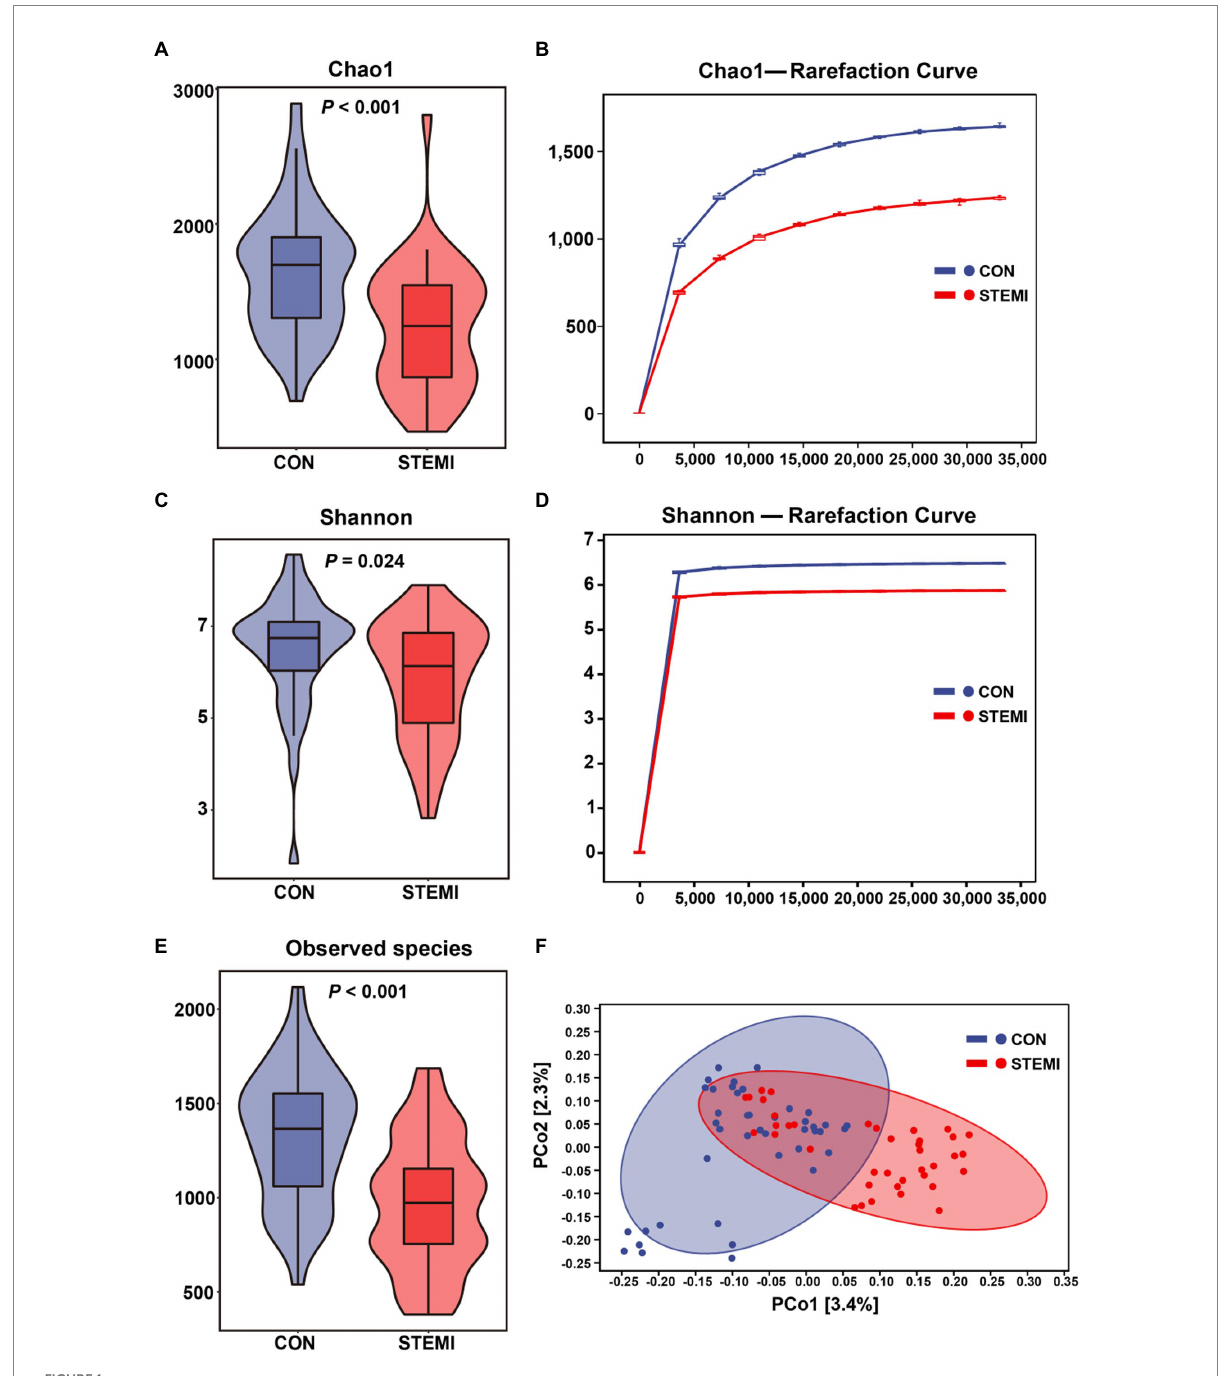
FIGURE 1 Physiological and microbial diversity in the two groups. (A) Chao1 index. (B) Chao1 curves for each group. (C) Shannon index. (D) Shannon curves for each group. (E) Observed species. (F) PCoA based on Jaccard distances of the physiological indexes among the two